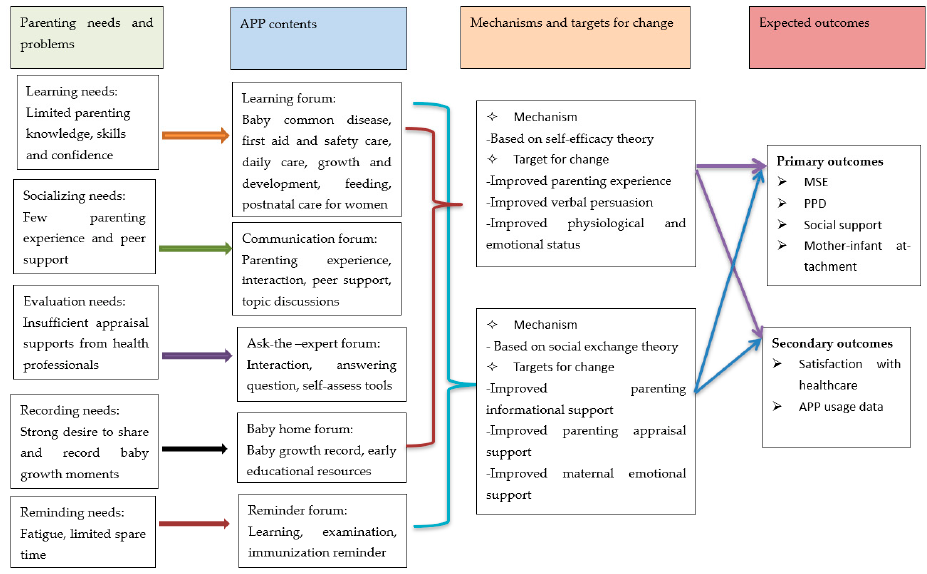
Figure 3. Logic model for “ISP”APP to support new mothers with parenting and mental well-being.